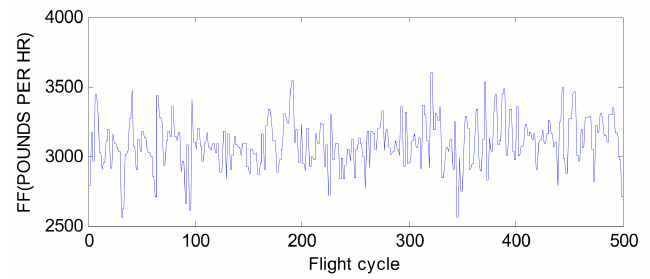
Figure 7. Aeroengine fuel flow